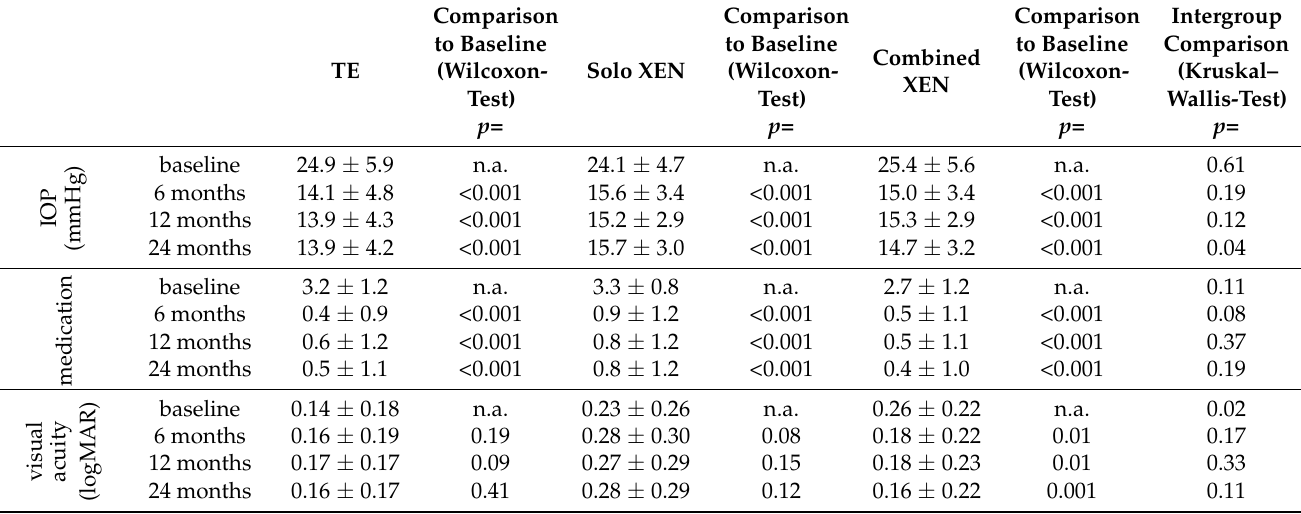
Table 2. Baseline and follow-up results for IOP, prescribed medication and visual acuity in the three treatment groups included (TE, solo XEN, combined XEN) with results of statistical analysis. IOP: intraocular pressure. n.a.: not